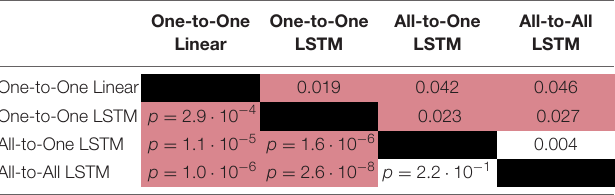
TABLE 4 | Paired absolute differences in mean value of the RMSE metric across recording sessions (upper triangular part of table), and corresponding p -values (lower triangular part of table), separating regression methods.